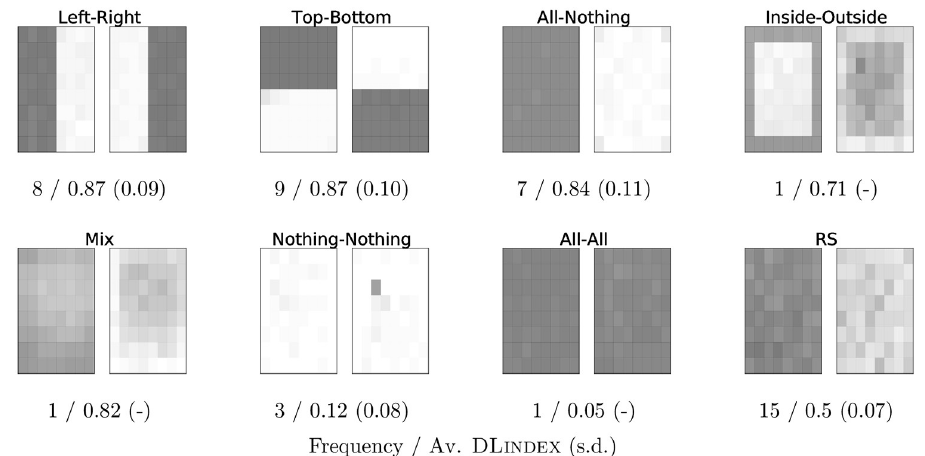
Fig 3. The eight types of splits of the grid that could be observed from our data. Each panel shows two grids, one for each player, with the regions uncovered through 60 rounds (on unicorn absent trials). The darker the tile, the more times it was uncovered by the player across all rounds. For each type we also show the observed frequency and the average DL INDEX with its standard deviation.